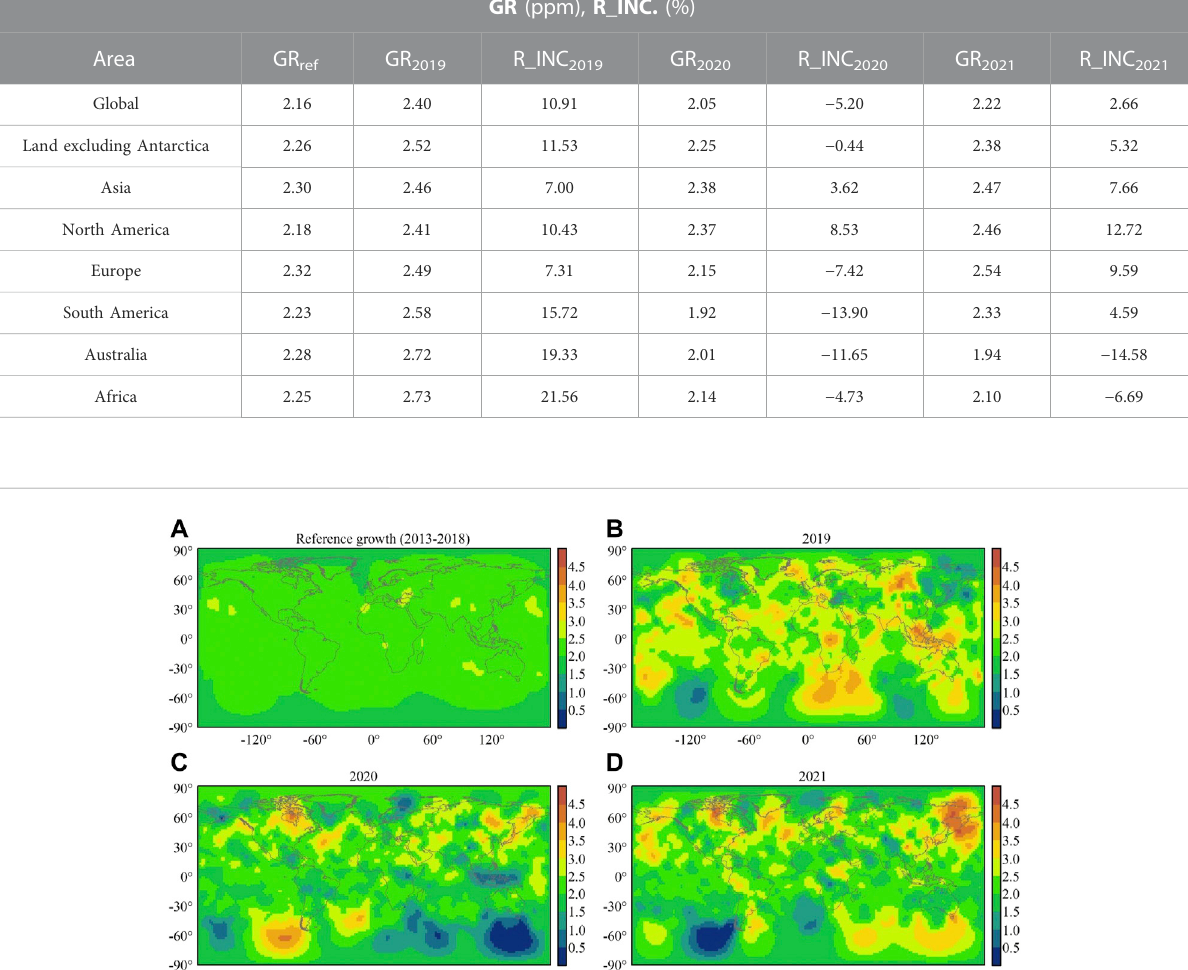
TABLE 2 The year-to-year growth of atmospheric XCO 2 and the relative increase globally and on six continents in 2019, 2020, and 2021. GR (ppm), R_INC.